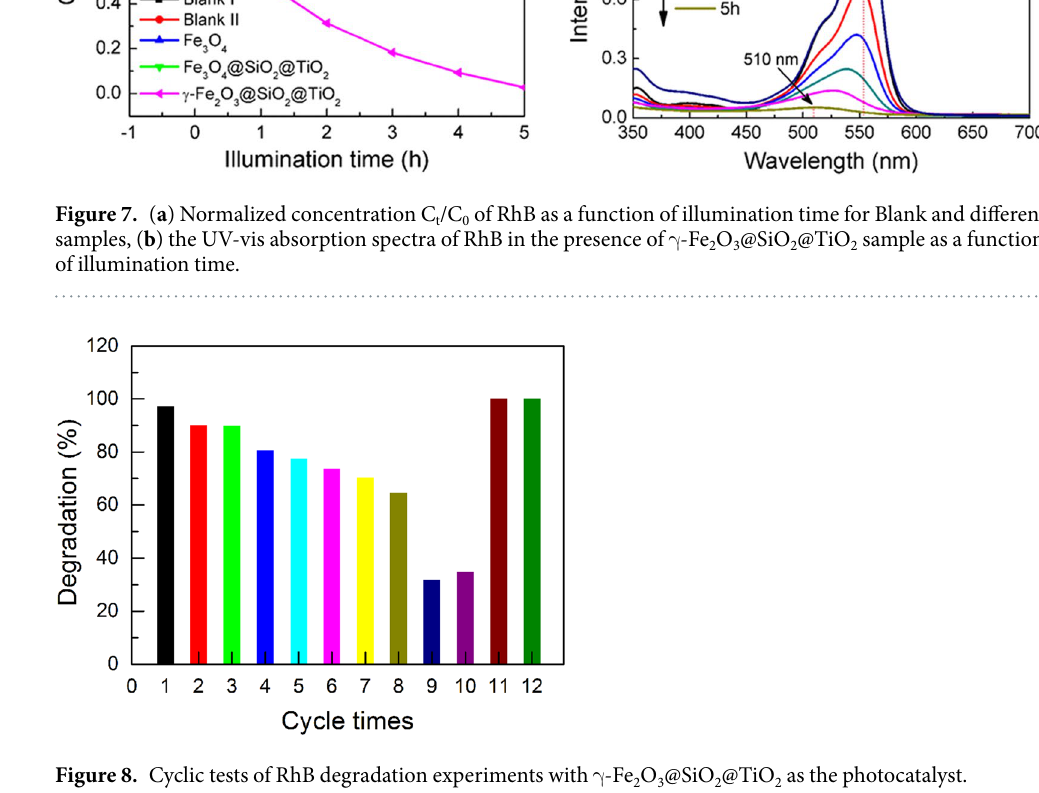
Figure 8. Cyclic tests of RhB degradation experiments with γ -Fe 2 O 3 @SiO 2 @TiO 2 as the